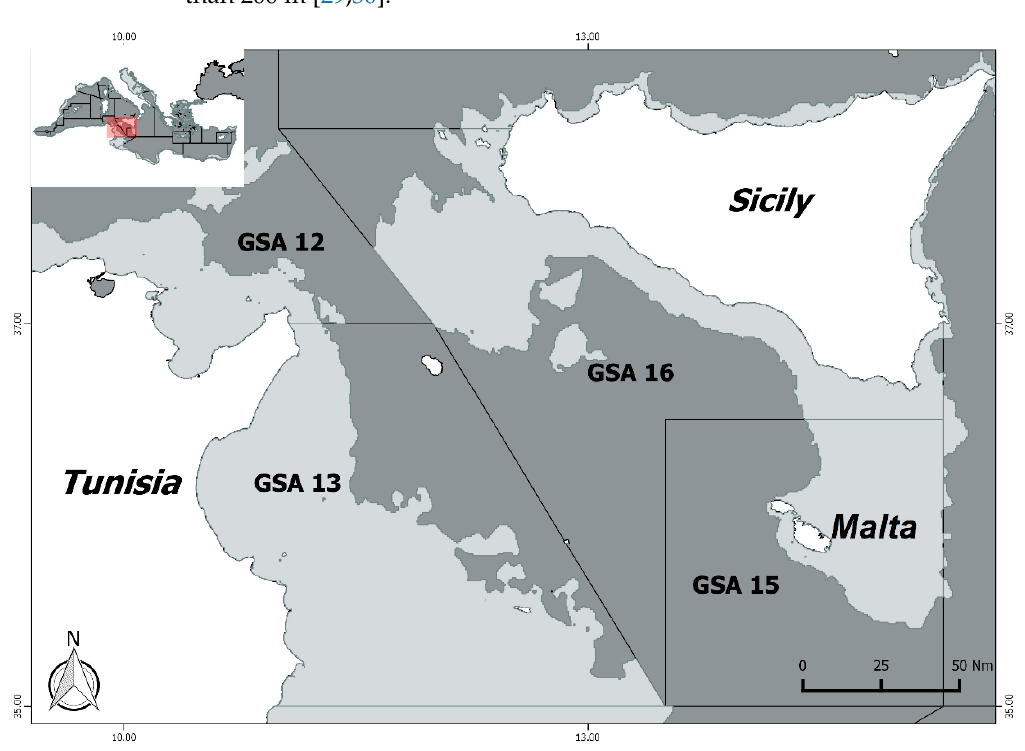
Figure 1. The sampling area covered by the MEDITS survey in the Strait of Sicily. Samples were collected during the international bottom trawl survey in the